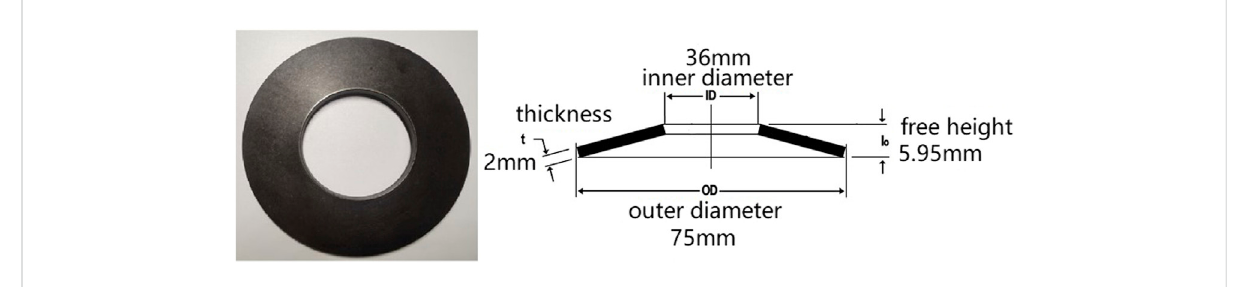
FIGURE 2 Outline and parameters of a piece of disc spring.